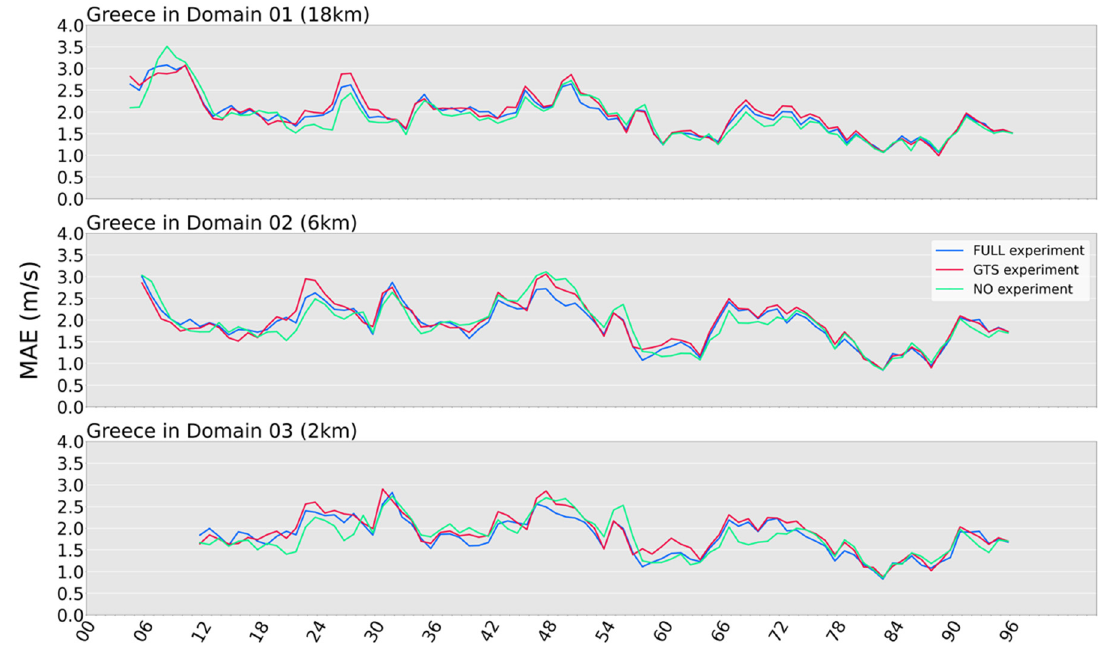
Figure 9. Hourly time series of 10 m wind speed MAE for the area of Greece. Each panel refers to a specific spatial resolution domain and the scores achieved for each type of experiment (i.e., FULL, GTS, NO). The blue lines represent the FULL experiment, the GTS experiment is depicted in red, and the NO experiment is depicted in green.